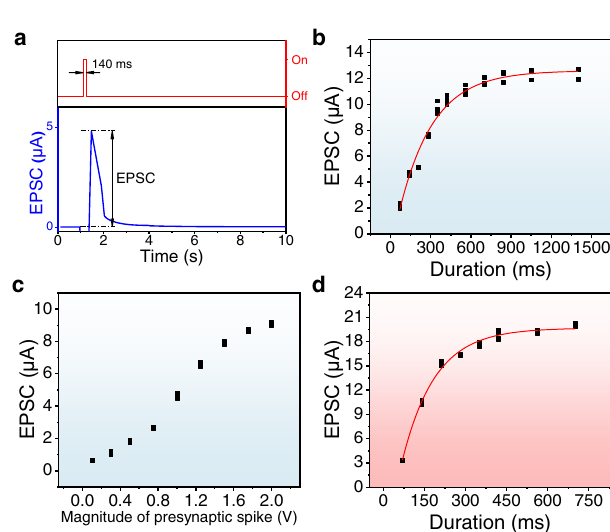
Fig. 5 | Recti fi cation of TENG and ionic logic gates by GPE ionic diodes. a a rectifying circuit to converting AC produced by TENG; b capacitor voltage of the TENGasafunction of time; c A circuitdiagram ofanionic ORgate.Aand Bare the input terminals and C is the output terminal; d performance of ionic OR gate. Square waves with are programmed as binary inputs A and B for the OR gate.